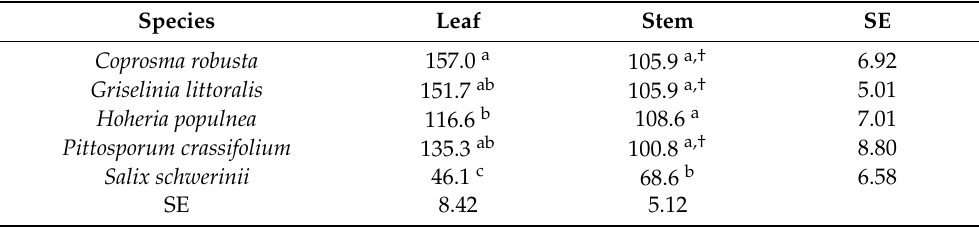
Table 4. Total gas production in milliliters per gram of dry matter (mL/g DM) from the in vitro fermentation of leaf ( n = 20) and stem ( n = 20) material from native ( Coprosma robusta , Griselinia littoralis , Hoheria populnea , and Pittosporum crassifolium ) and exotic ( Salix schwerinii ) shrub species.